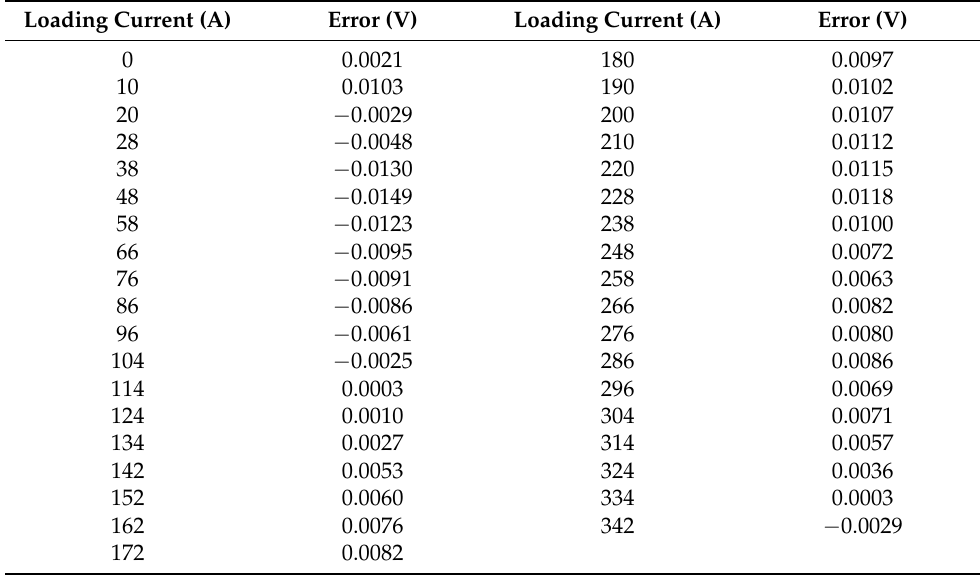
Table 6. The error between the simulated data and the actual